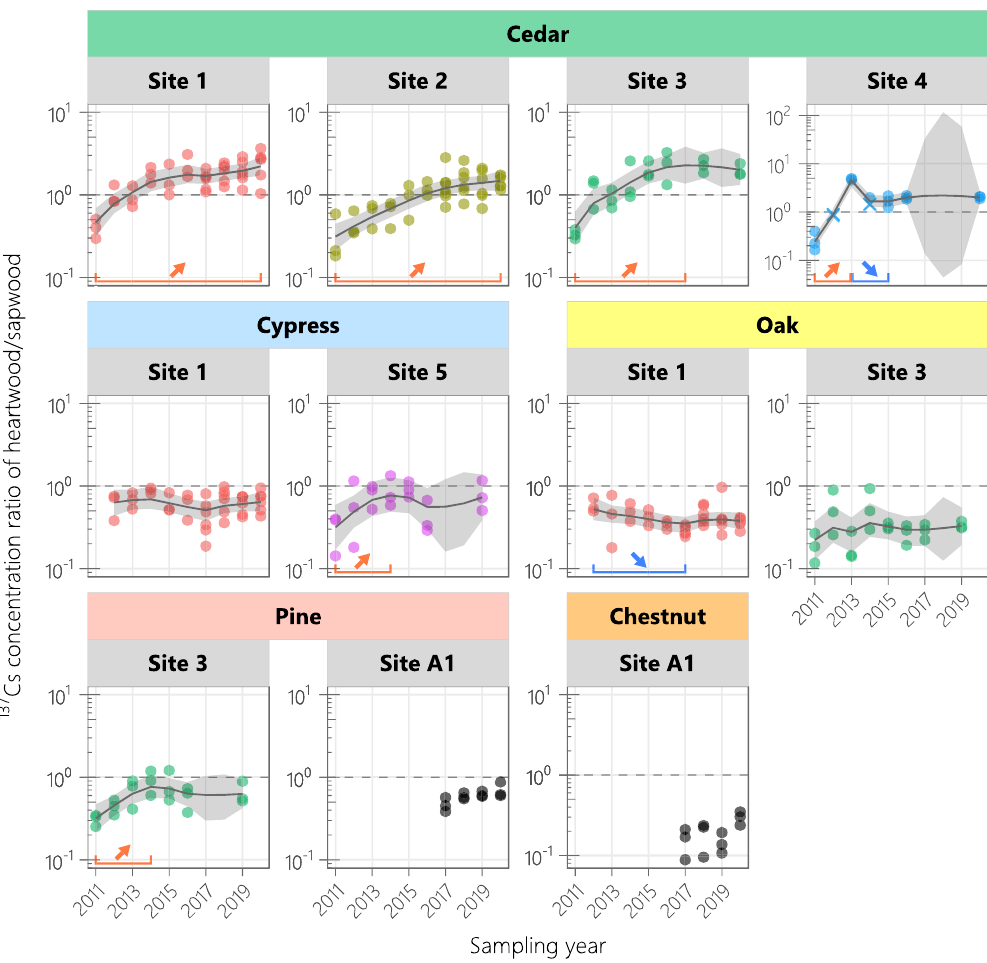
Figure 4. Temporal variations in 137 Cs concentration ratio of heartwood/sapwood. Circles show the observed values, and crosses are the calculated values using the detection limits. The true states were estimated using a dynamic linear model, and the median values and 95% credible intervals are shown by solid lines and shaded regions , respectively. Horizontal lines indicate significant differences between the estimated true state values in the years at the both ends (delimiting years). Data from 2011 to 2016 were provided in previous studies 8,25